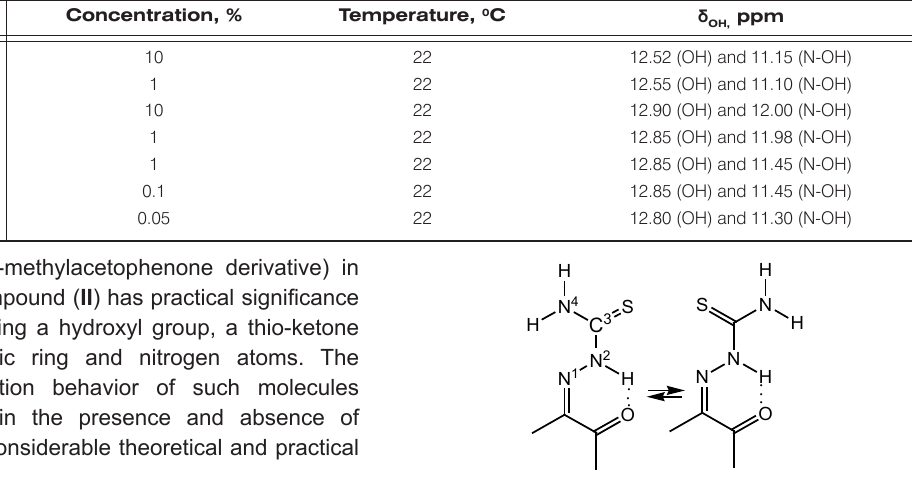
Table 2. Chemical shifts of hydroxyl protons ( δ